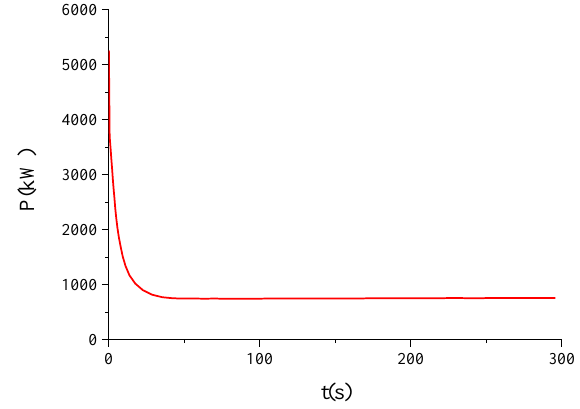
Figure 6. Time-domain calculation of fixed wind turbine power.